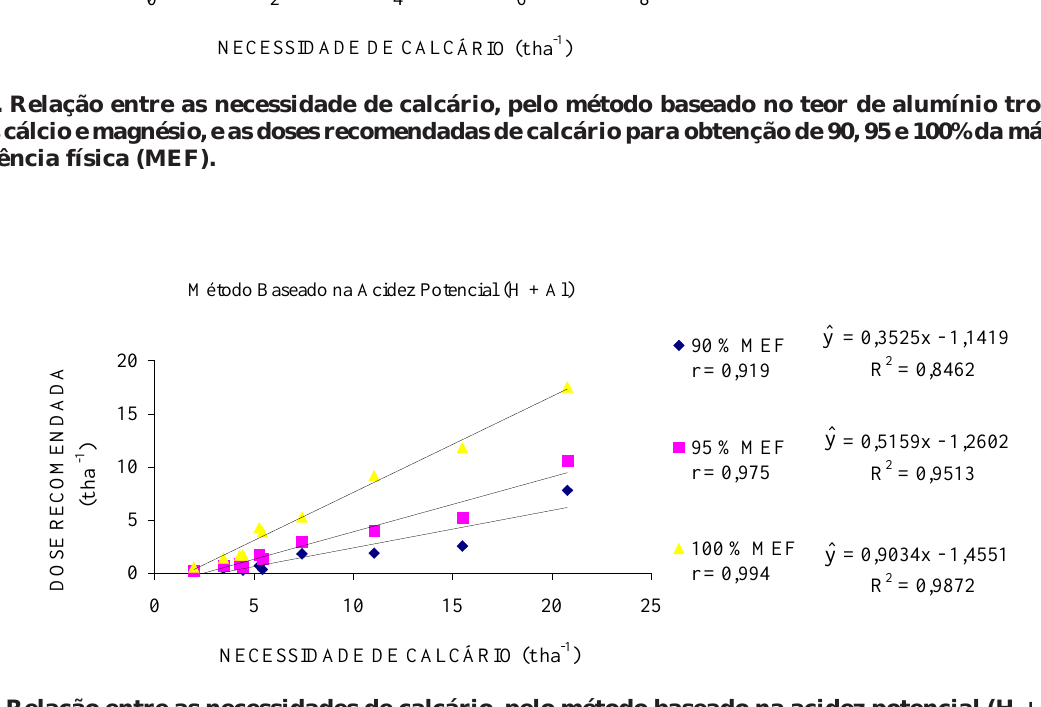
Figura 5. Relação entre as necessidades de calcário, pelo método baseado na acidez potencial (H + Al), e as doses recomendadas de calcário para obtenção de 90, 95 e 100% da máxima eficiência física